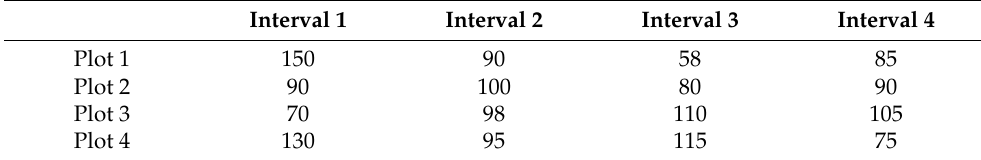
Table 6. Nutrient amendments on plots in Kg/ha.